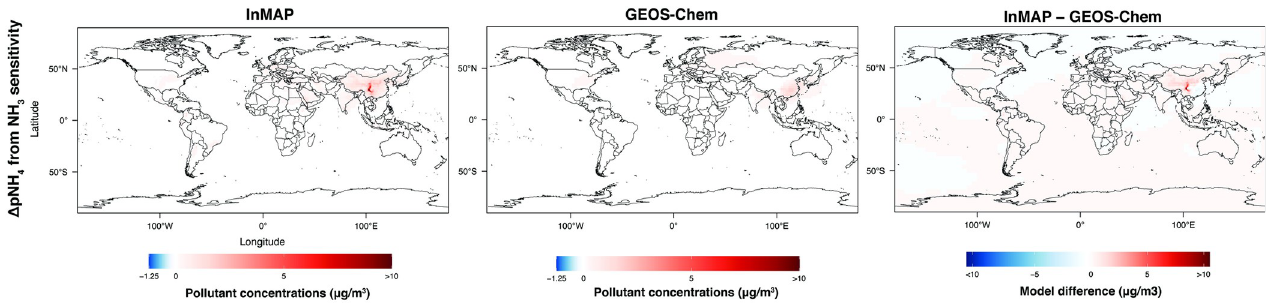
Fig 13. Comparison between Global InMAP and GEOS-Chem for predicting changes in pNH 4 concentrations from a 100% increase in NH 3 emissions from agricultural